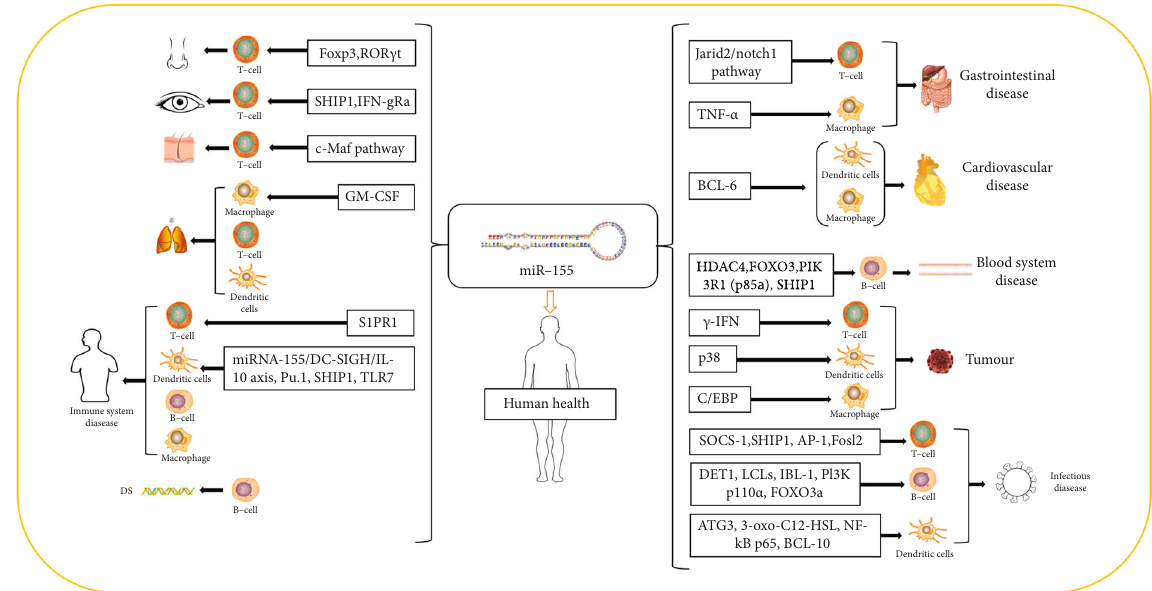
Figure 2: Main roles of